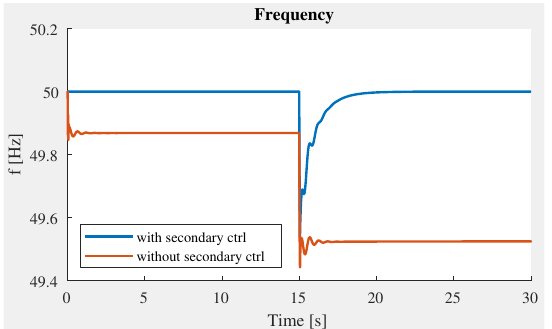
Figure 9. System frequency.